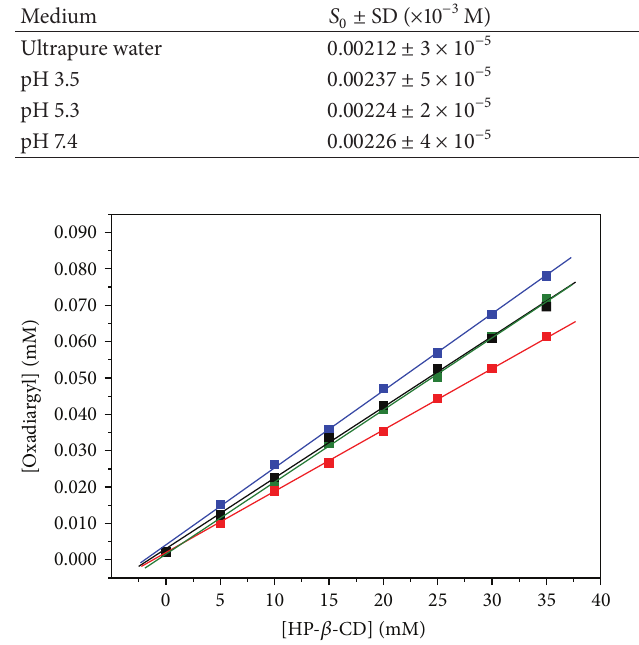
Figure 3: Phase-solubility diagram for oxadiargyl and increasing concentrations of HP- 𝛽 -CD in (Black Line) ultrapure water, (Blue Line) acetate buffer pH 3.5, (Red Line) acetate buffer pH 5.3, and (Green Line) phosphate buffer pH 7.4. Each point represents the mean of three determinations. Figure 4: